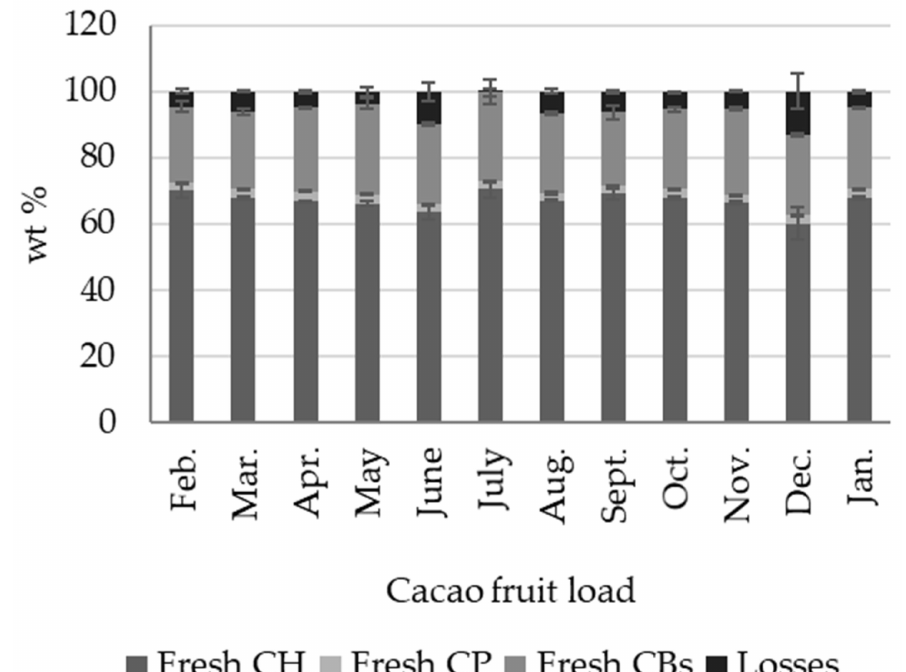
Figure 2. Seasonal variations in the percentage weight of fresh cacao fruit biomass outputs, cacao husk (CH), cacao placenta (CP), and cacao beans (CBs), derived from the traditional approach of cacao fruit processing (first stage, Figure